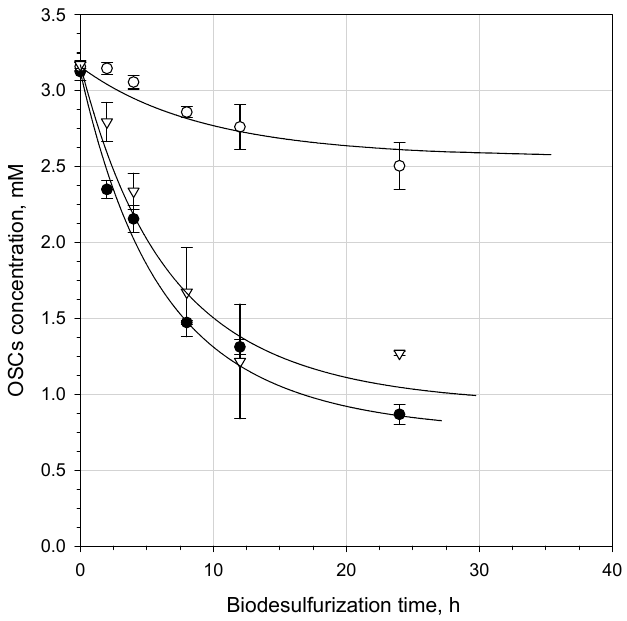
Figure 11. Time course of biodesulfurization of different OSCs by R. erythropolis IGTS8 resting cells. Symbols : ( λ ) 4-MDBT, ( σ ) 4,6-DMDBT, and ( ◯ ) 4,6-DEDBT. Solid line represents model fitting (Equation (6)). Table 3. Kinetic constants for the biodesulfurization of different OSCs (Equation (6)). OSC